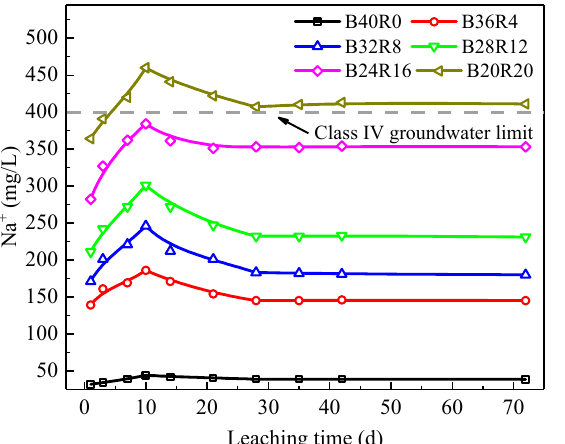
Figure 9. Variation diagram of alkali concentration in semidynamic toxicity leaching test solution.